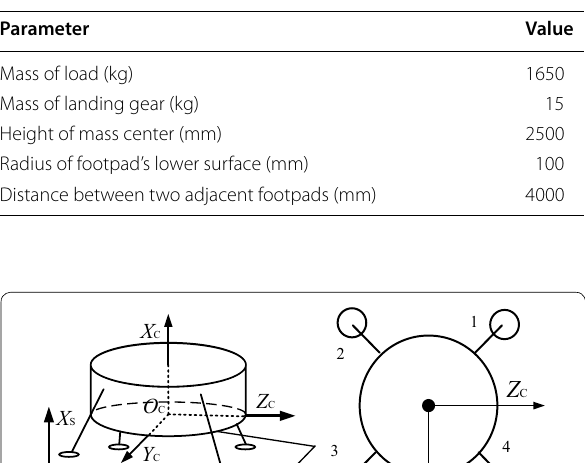
Table 1 Parameters of the lander at touchdown